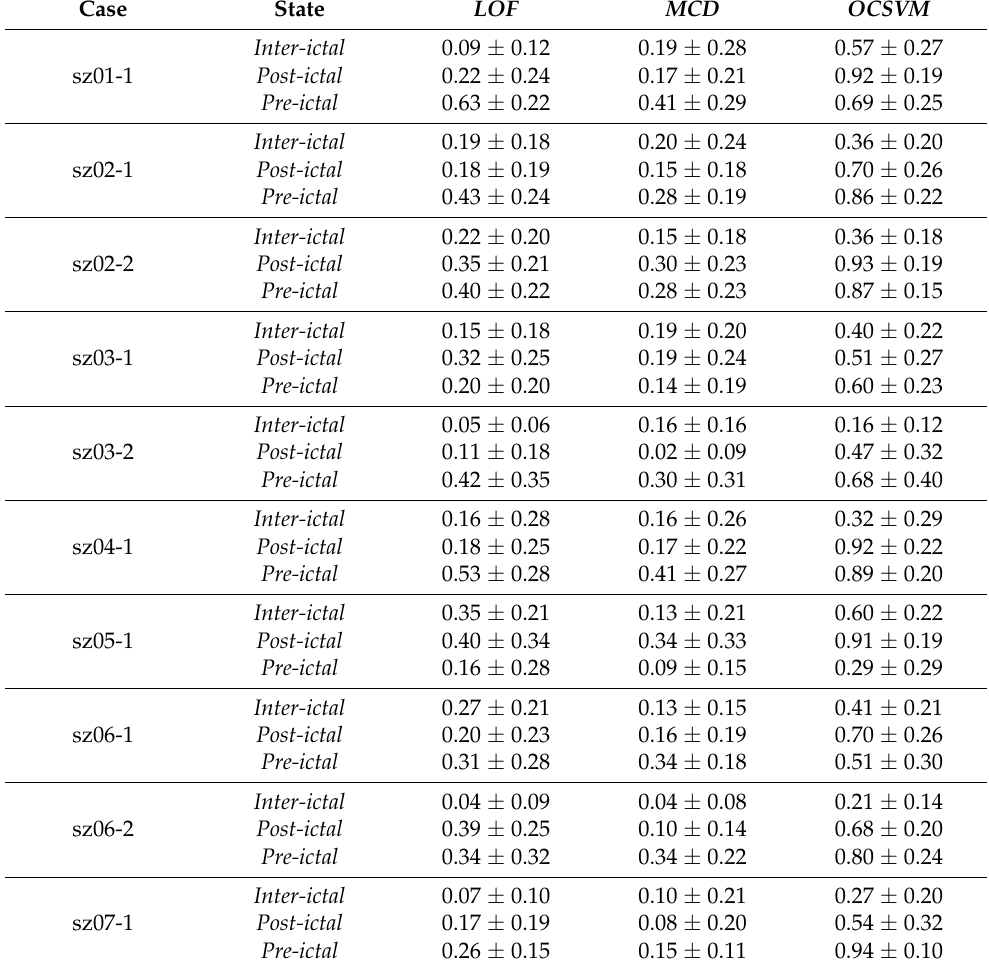
Table 6. Min-max scaled average score ( ± standard deviation) at different ictal states per model 1 .